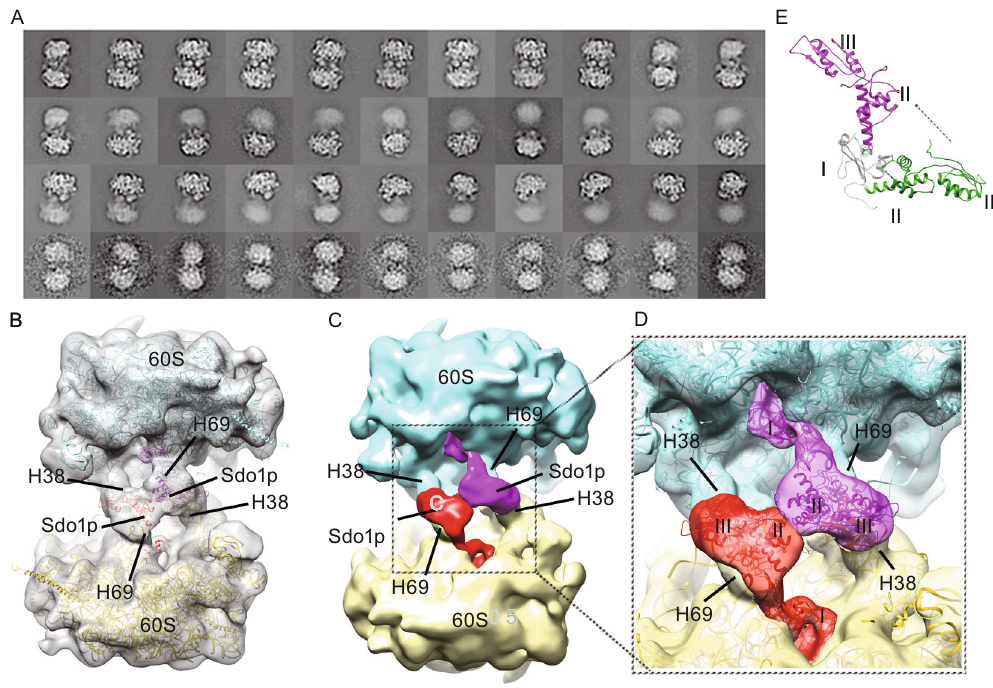
Figure 4. The cryo-EM structure of dimeric 60S-Sdo1p complex. (A) Reference-free 2D classi fi cation of selected particles of the 60S dimers. (B) Overview of cryo-EM density map of the dimeric 60S-Sdo1p complex, superimposed with fi tted models. (C) Same as (B), but with two 60S subunits and two copies of Sdo1p separately colored. (D) Zoom-in view of boxed region in (C). (E) Comparison of Sdo1p in its 60S-bound conformation with that derived from homology modelling (see MATERIALS